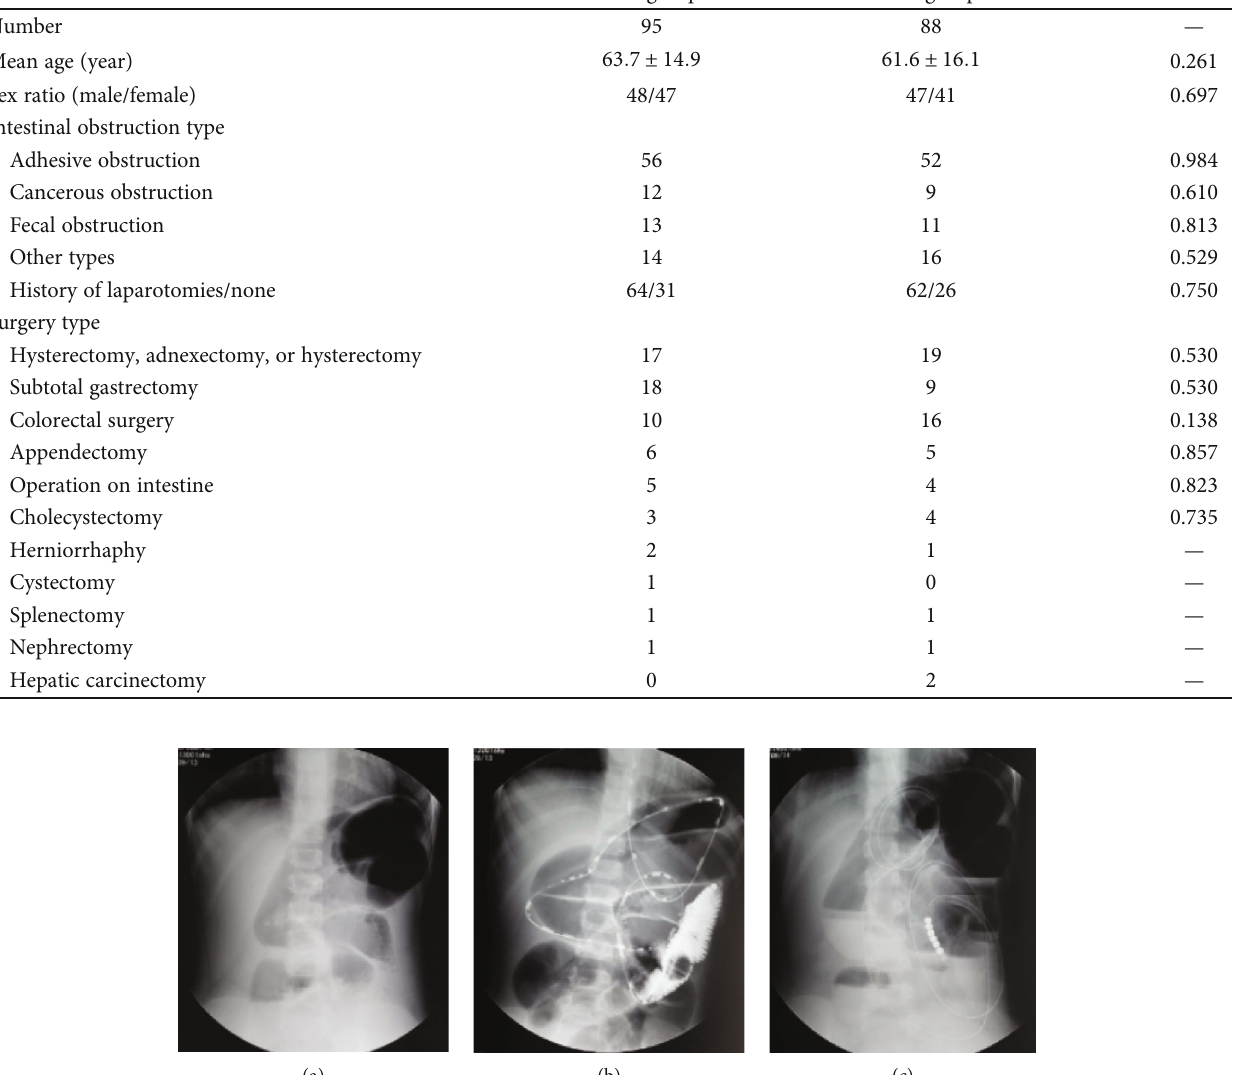
Figure 2: Presentative abdominal X-ray plain fi lms of the TIT procedure. (a) Before intubation, the proximal intestinal canal dilated obviously according to the plain fi lms. (b) The patient was treated with the TIT procedure, and the intubation depth was 135cm. (c) 24 hours after intubation, the dilatation of intestine was